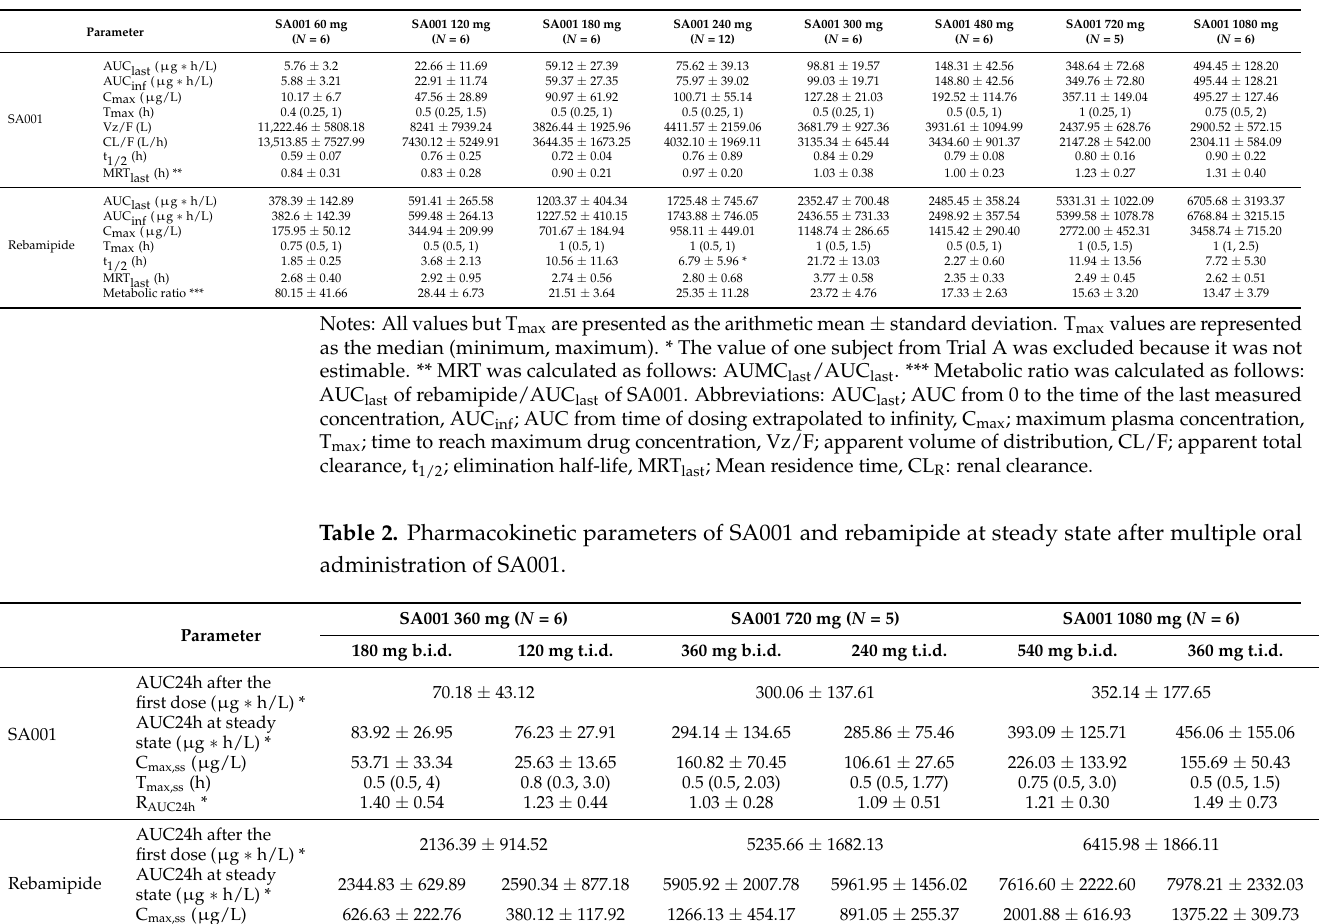
Table 1. Pharmacokinetic parameters of SA001 and rebamipide after single oral administration of SA001.